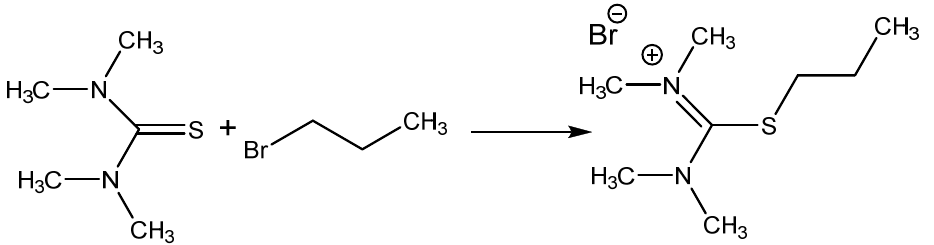
Scheme 8. Preparation of catalytically active S-alkylisothiouronium salt [55].